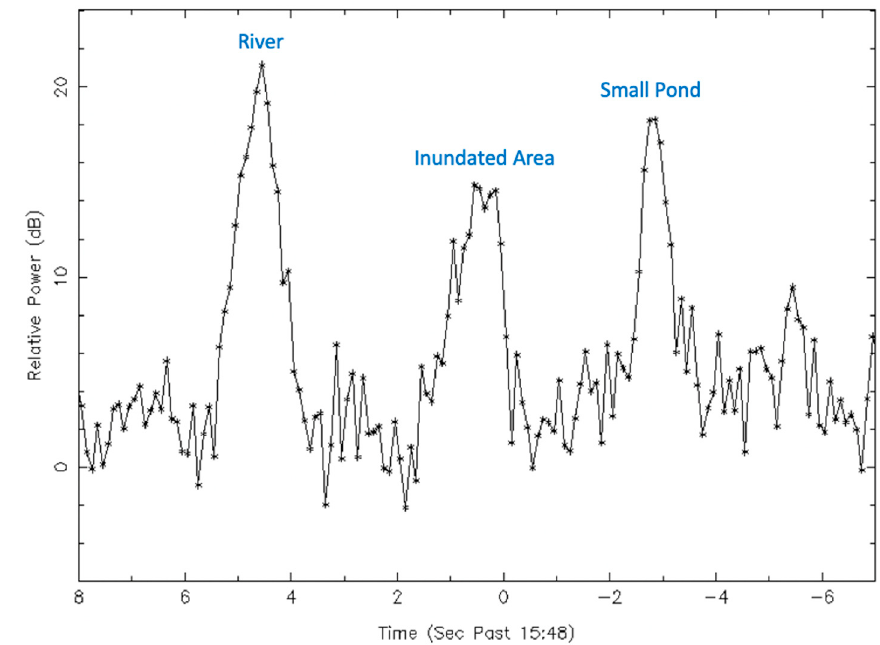
Figure 4. Received power vs. time corresponding to the westward ground track in Figure 3. Note that time increases to the left to align with Figure 3 features. Points are 0.1 s apart, and the aircraft velocity was 81 m /